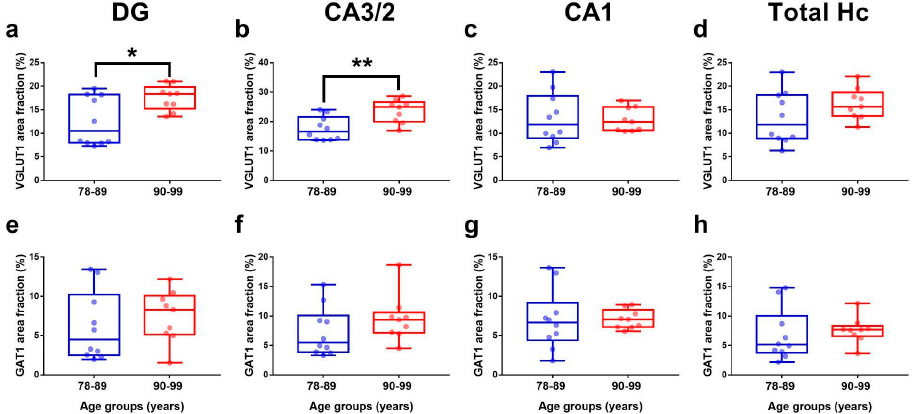
Figure 3. VGLUT1 ( a – d ) and GAT1 ( e – h ) area fractions in the hippocampus from non-demented donors grouped by age. Donors were divided into 78–89 (blue) or 90–99 (red) year-old groups. Student t -tests between these groups were performed in the DG, CA3/2, CA1, and total hippocampus (Hc). Data are presented as boxplots with lines at the mean. * p -values < 0.05, ** p -values < 0.01. The VGLUT1 and GAT1 hippocampal area fractions were also compared between the male and female groups. No sex differences were found between the VGLUT1 area